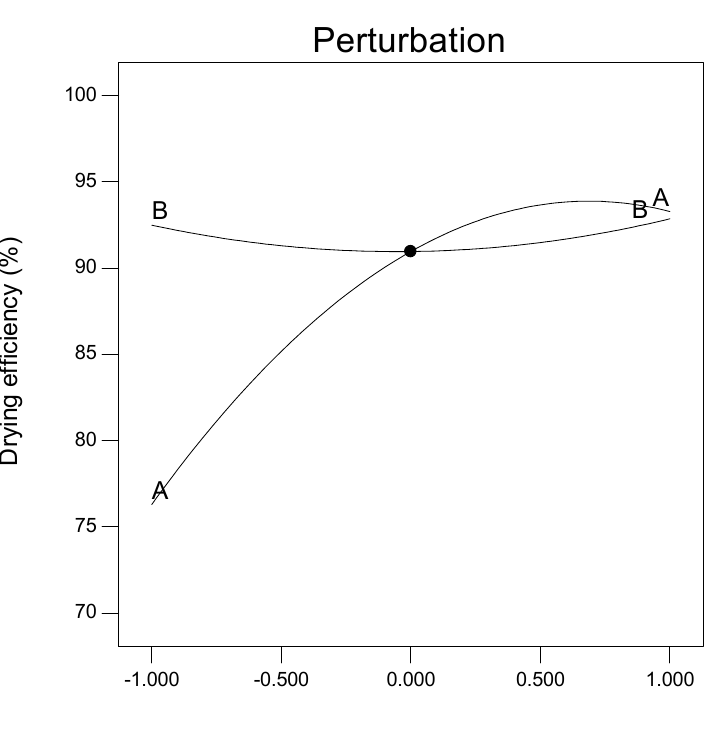
Figure 3. Perturbation plot showing the effect of the air temperature: A and air velocity: B.